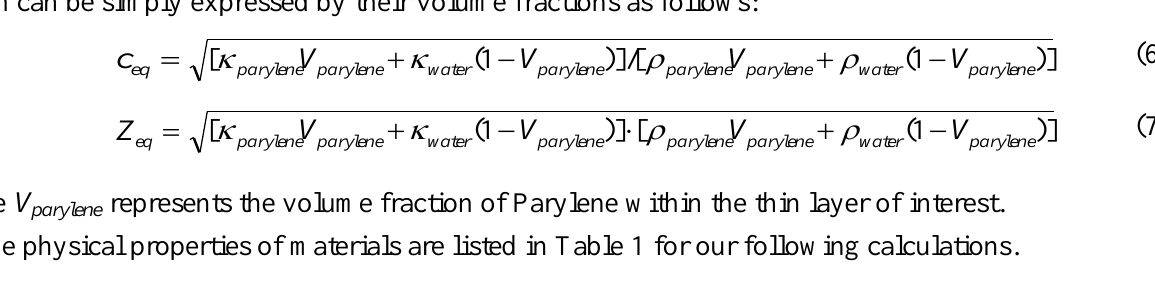
Table 1. Physical properties of materials for